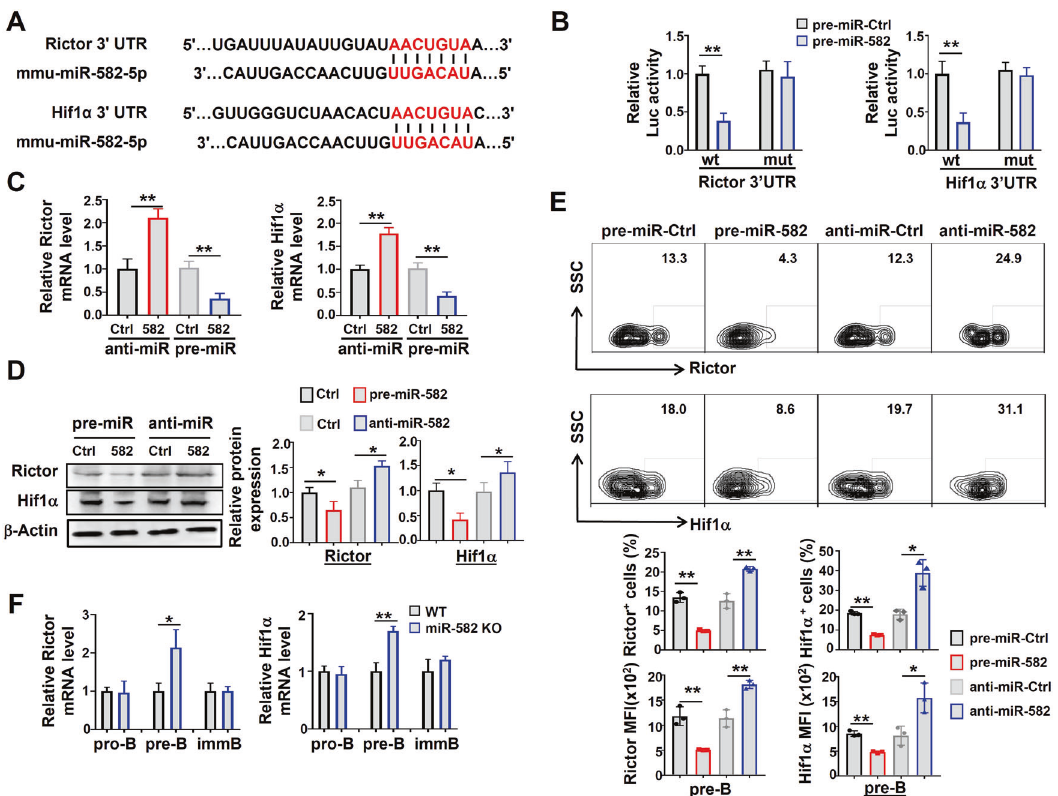
Fig. 5 miR-582 downregulates Rictor and Hif1 α by directly targets their 3 ′ UTR in pre-B cells. A Aligment of the seed sequence of murine miR-582-5p with murine Rictor and Hif1 α 3 ′ UTR. Complementary bases are marked with red color. B HEK293T cells were transfected with miR- 582-5p and different 3 ′ UTR reporters of Rictor or Hif1 α for 72 h. Luciferase activity in cell lysates were determined by the dual luciferase reporter assay ( n = 5). C , D pre-B cells were infection with pre-miR-582 or anti-miR-582 lentivirus or their controls for 72 h, and Rictor and Hif1 α mRNA and protein were determined by qRT-PCR ( C ) and Western blotting ( D ), respectively, with β -actin as an internal control ( n = 5 – 6). E Pre-B cells were infected with pre-miR-582 or anti-miR-582 lentivirus or their controls. The expression of Rictor and Hif1 α in pre-B cells was determined by FACS after cytoplasmic staining, and quantitatively compared using the median fl uorescence intensity (MFI) and the proportion of positive cells ( n = 3). F Pro-B, pre-B, and imm-B cells were FACS-puri fi ed from the control and miR-582 KO mice, and the expressions of Rictor and Hif1 α was determined by qRT-PCR ( n = 3). Bars represent means ± SEM, * P < 0.05, ** P <